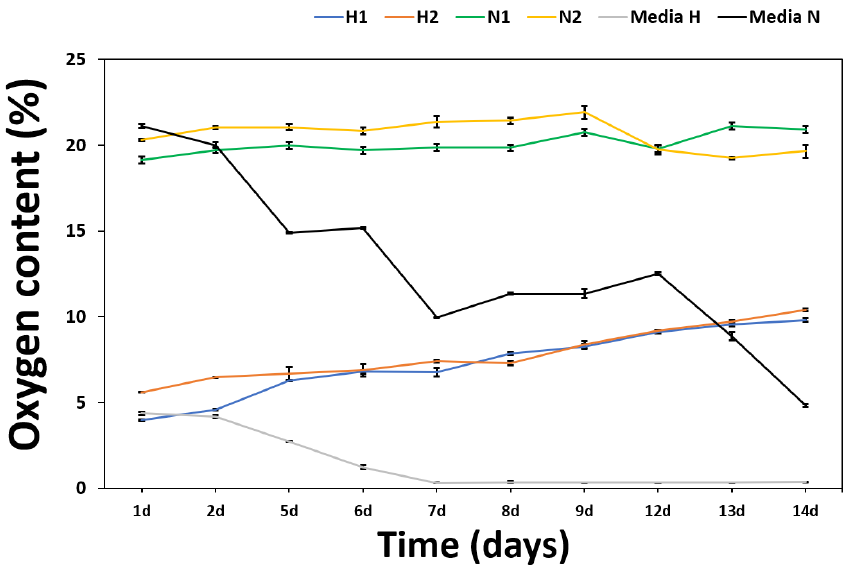
Figure 2. Oxygen content of media containing PMO-PFC particles and particle-free media under normoxic and hypoxic conditions. N1, H1 are the measurement values under normoxic and hypoxic conditions of media with PMO-PFC, respectively. N2, H2 are the measurement values under normoxic and hypoxic conditions, respectively, when PMO-PFC is flushed with 100% O 2 . The number of experiments is three.